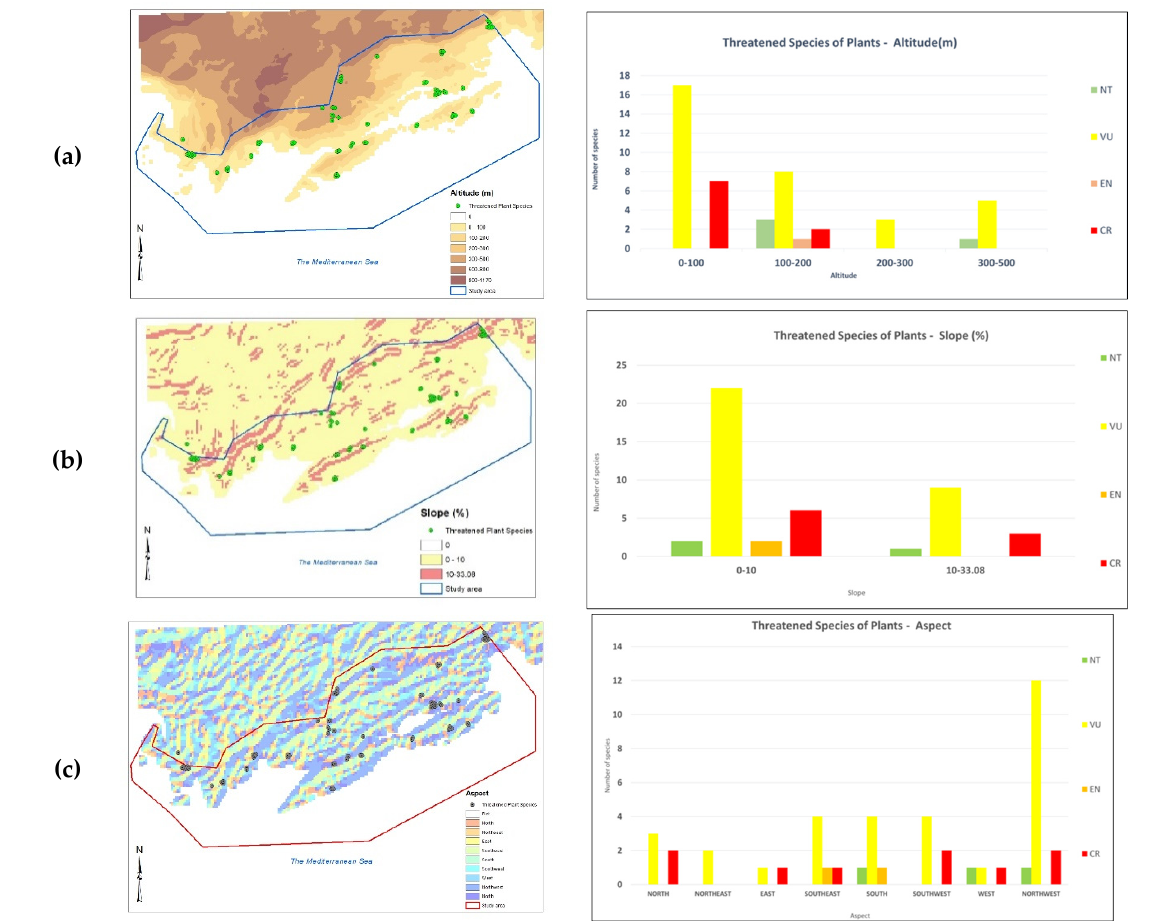
Figure 9. The distributions of endemic flora species (Table 1) observed during the field works on the altitude range (a), slope (b) and aspect (c) maps.